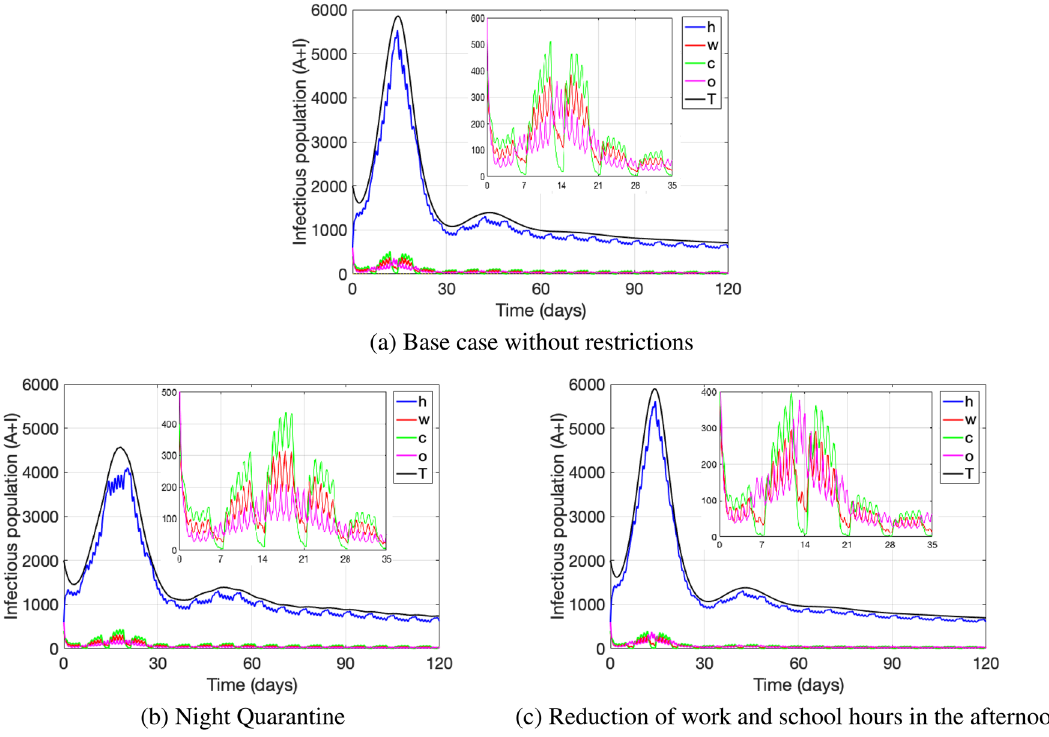
population—at each location: home ( h , blue), work ( w , red), school ( c , green) and other ( o , pink); as well as the total number of active cases ( T , black). The subplots show the curves under: ( a ) the base-case without restrictions; ( b ) a strict night-quarantine, obtained by reducing the parameters α x and α i x , x ∈ { w , c , o } to zero for the time-blocks between 9:00 p.m. and 5:00 p.m.; ( c ) a restrictive measure reducing the time spent at work and school (represented by the parameters σ w and σ c ) in the afternoon by half during the time-blocks from 1:00 p.m. and 5:00 p.m. and from 5:00 p.m. to 9:00 p.m. The parameter values used are as in Table